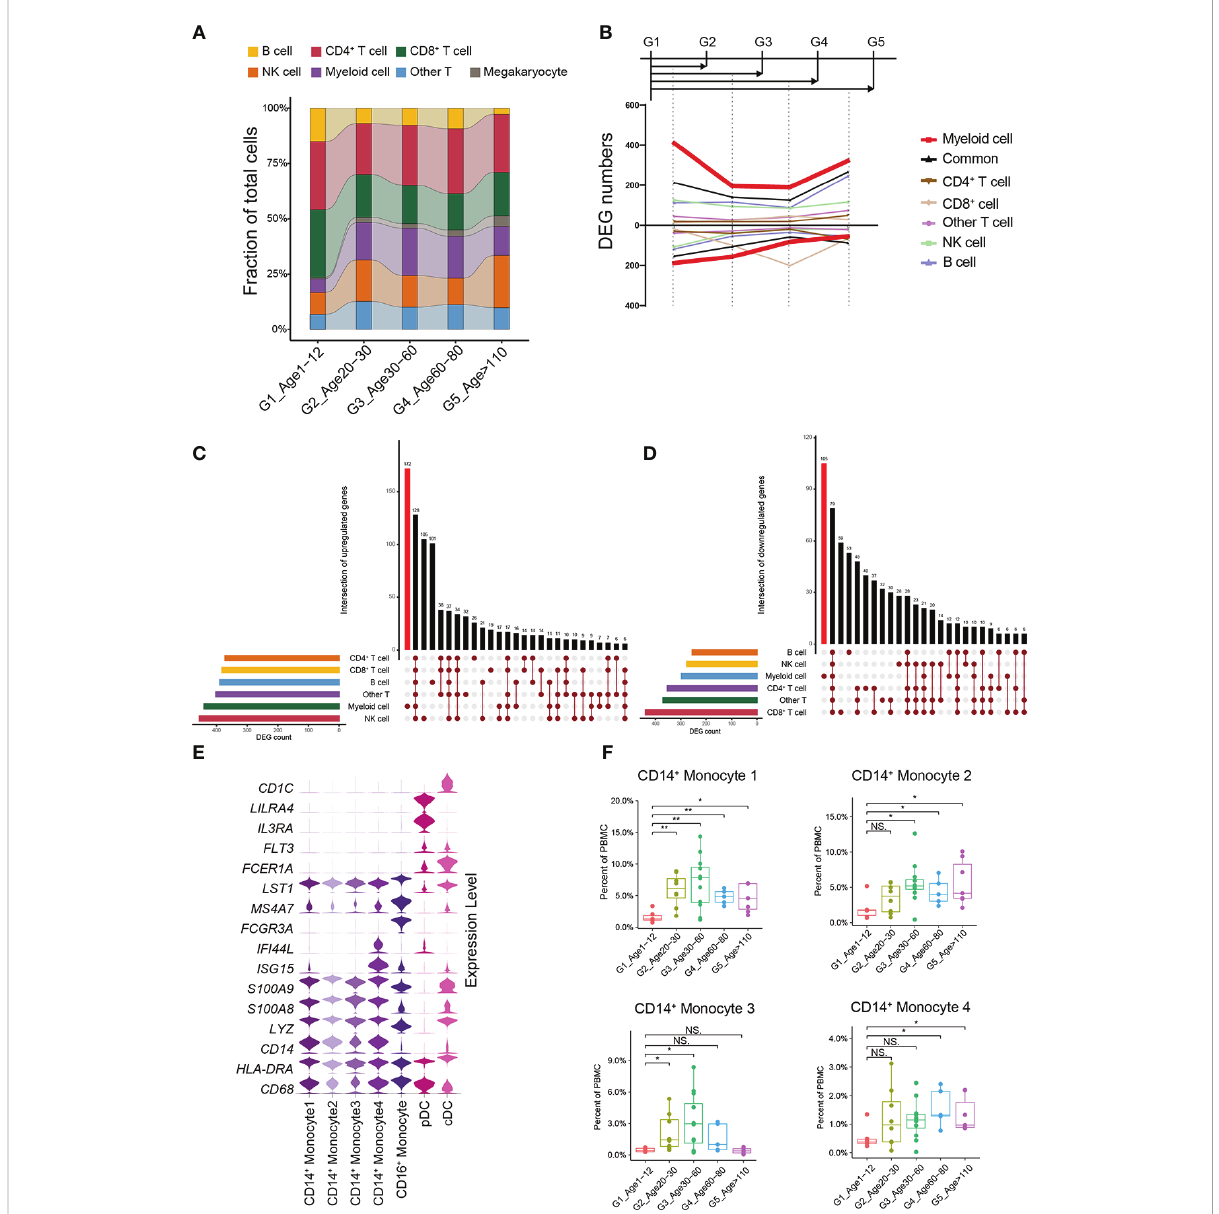
FIGURE 2 Changes in cellular proportion and molecular characteristics with age. (A) Composition of the main cell types in the 5 age groups. (B) Smoothed line plot displaying the number of speci fi c and common DEGs of different cell types for pairwise comparisons with a G1 reference. Positive (negative) values represent upregulated (downregulated) genes. (C) UpSet plot showing the integrated comparative analysis of upregulated DEGs in the main cell types between G1 and the other groups. Upregulated DEGs: upregulated in G1, downregulated in other groups. (D) UpSet plot showing the integrated comparative analysis of downregulated DEGs in the main cell types between G1 and the other groups. Downregulated DEGs: downregulated in G1, upregulated in other groups. (E) Violin plots showing the expression distribution of selected canonical cell markers in the 7 subtypes of myeloid cells. (F) Boxplots of the percentage of 4 CD14 + monocyte subtypes in PBMCs. All differences with P<0.01 are indicated. NS, not statistically signi fi cant; *P<0.01;